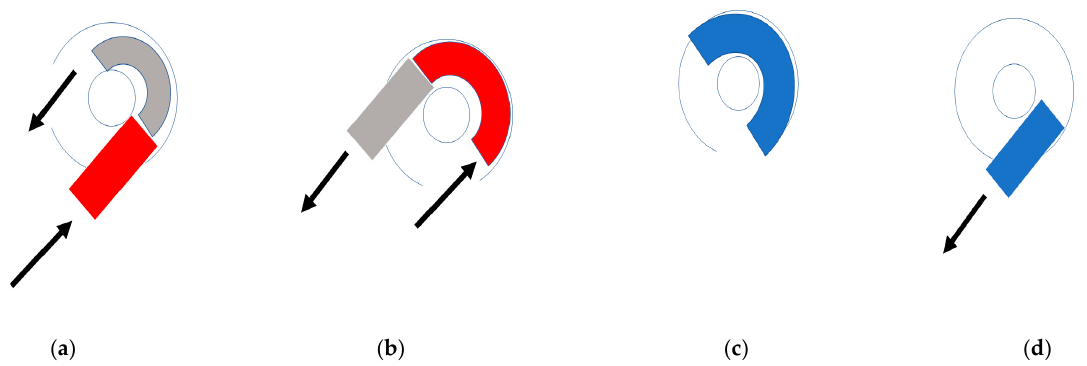
Figure 1. ( a , b ) The tumor (grey) behind the modiolus is pushed with a dry roll of Gelfoam (red) from the basal turn to the second turn access ( a , b ), until it can be removed at the second turn access. ( c , d ) The Gelfoam is rinsed by saline (change from red to blue). It swells and can be sucked out about the basal turn.